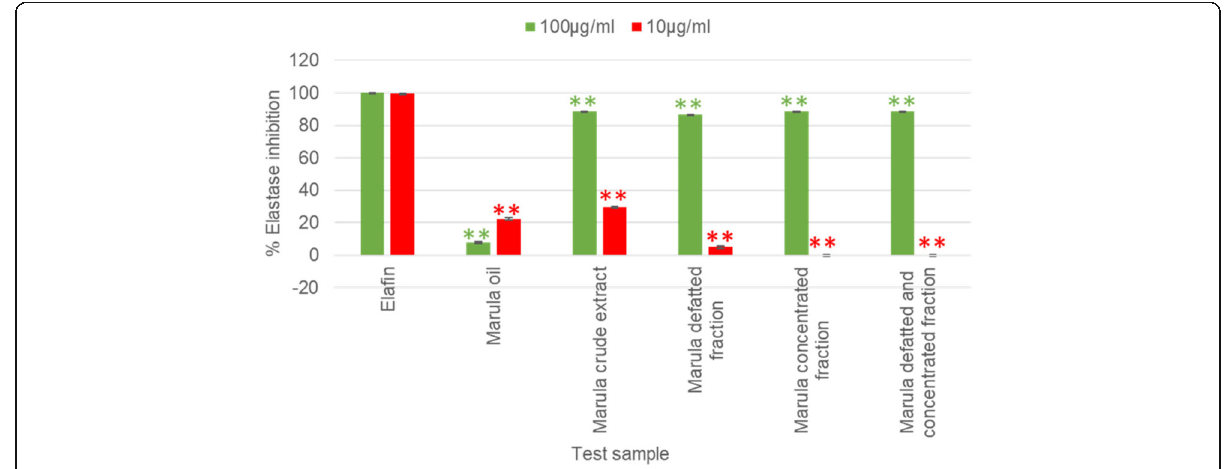
Fig. 1 Elastase inhibition of the improved quality samples and Marula oil at 100 and 10 μ g/ml (Error bars represent SEM, with n =3). = P <0.05, = P <0.01 represent a significant difference with elafin at 10 μ g/ml and = P <0.05, = P <0.01 represent a significant difference with elafin at 100 μ g/ml